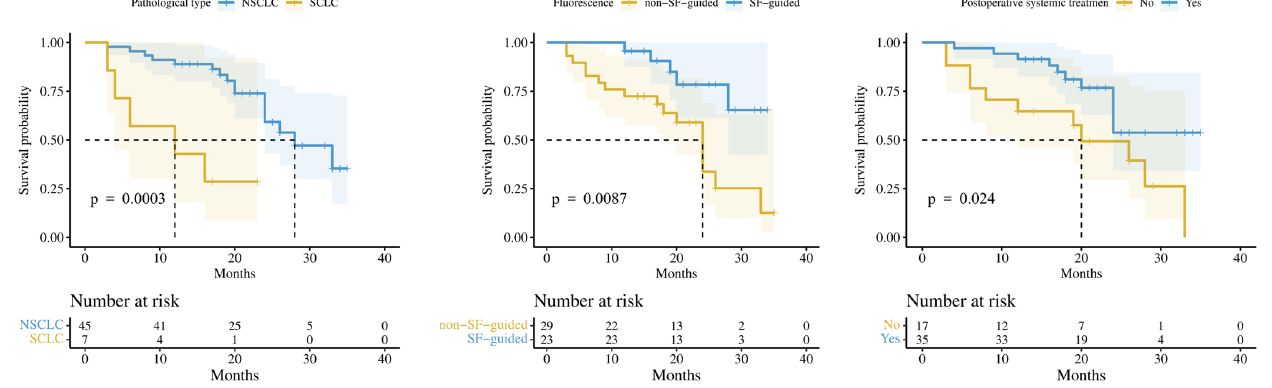
Figure 2. Kaplan–Meier survival curves in terms of pathological type (NSCLC vs. SCLC), fluorescence-guided surgery (SF-guided vs. non-SF-guided), and postoperative systemic treatment (Yes vs. No).